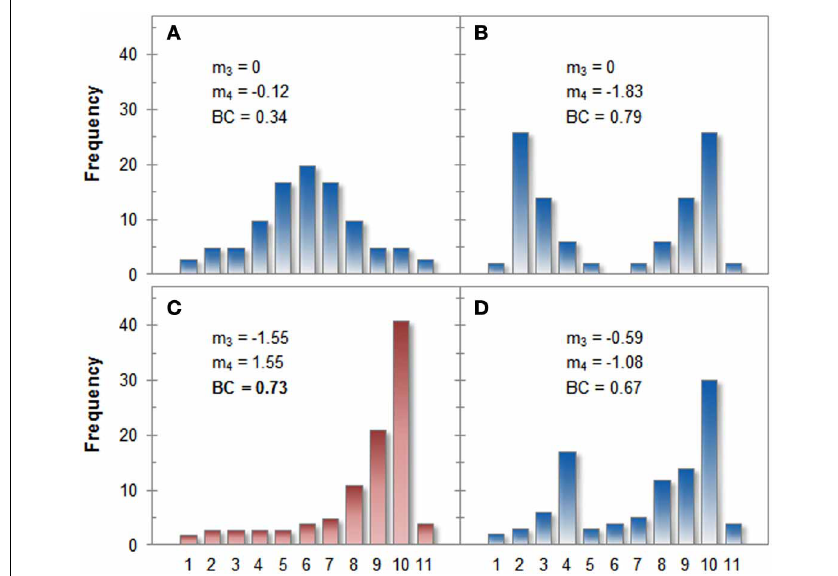
FIGURE 1 | Histograms for four hypothetical distributions, their skewness ( m 3 ) and kurtosis ( m 4 ), as well as the corresponding BCs (values exceeding 0.555 are taken to indicate bimodality). Panel (A) shows a clearly unimodal distribution whereas the distribution in Panel (B) is clearly bimodal. Both distributions are classified correctly by the BC. Panel (C) shows a skewed unimodal distribution that is classified erroneously as bimodal by the BC. The distribution in Panel (D) is correctly classified as bimodal, even though its BC is lower than that of distribution C. See the text for a detailed comparison of the